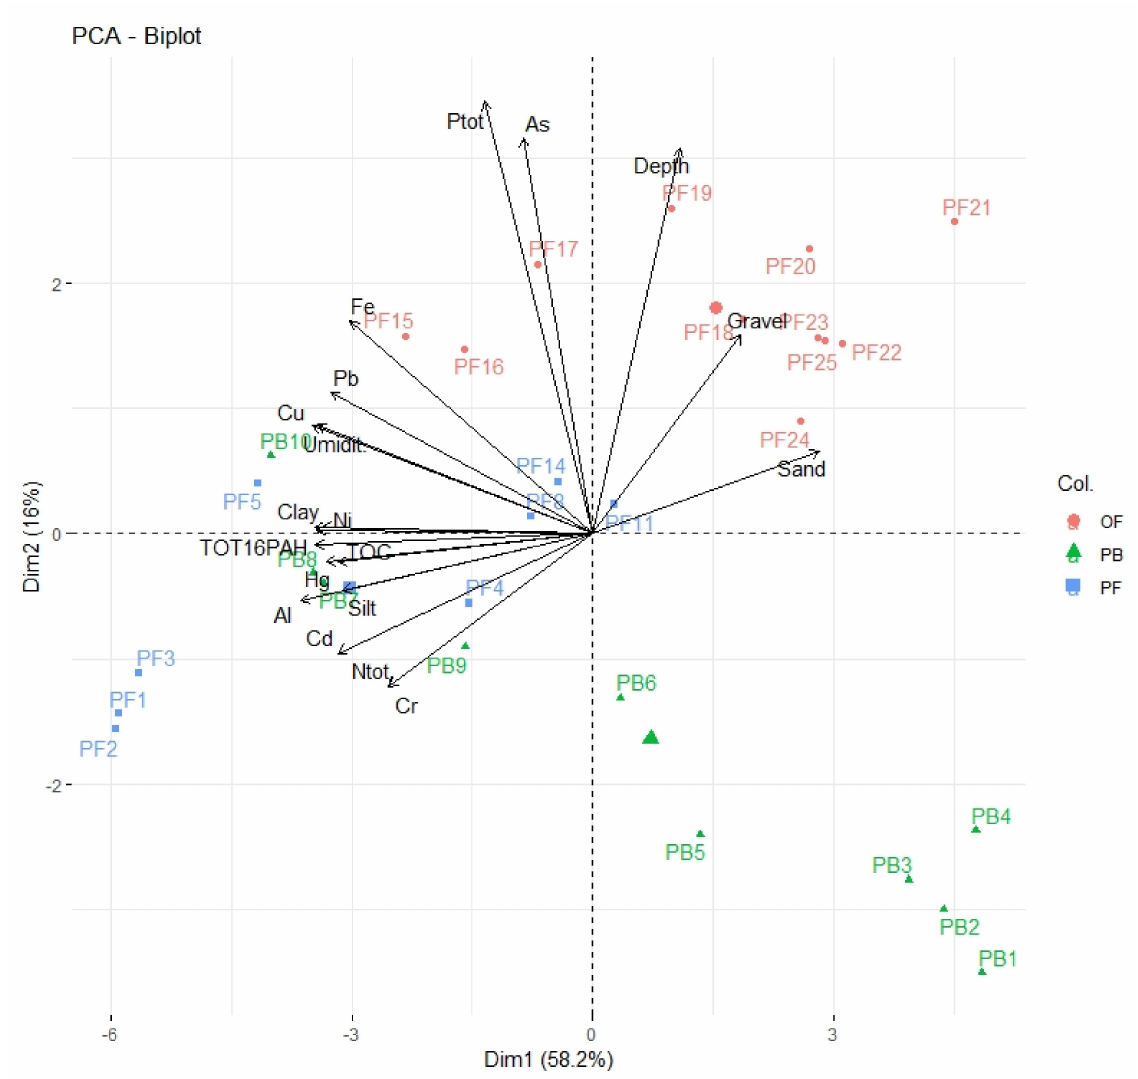
Figure 4. Correlation biplot showing relationship among concentrations of metals, the sum of 16 PAHs, and other sediment parameters. Ptot = total phosphorus, Ntot = total nitrogen, TOC = total organic